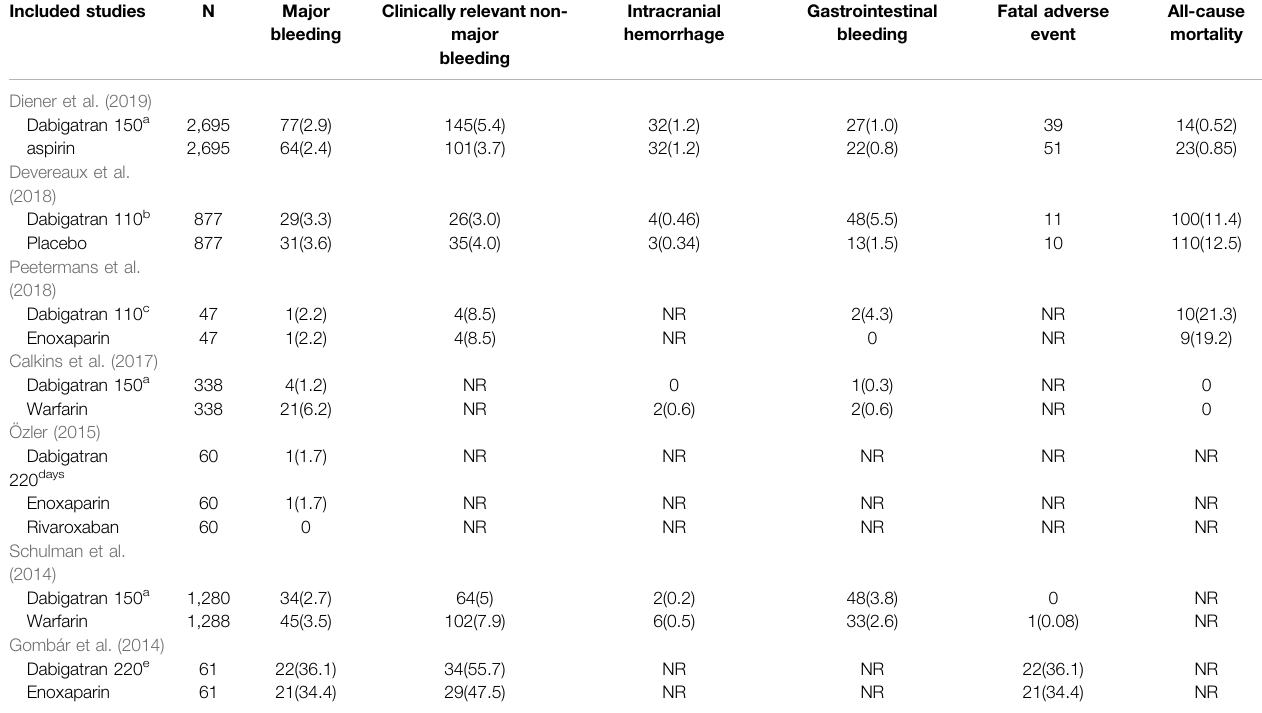
TABLE 2 | Study and patient characteristics of the seven trials comparing dabigatran with control group. Included studies